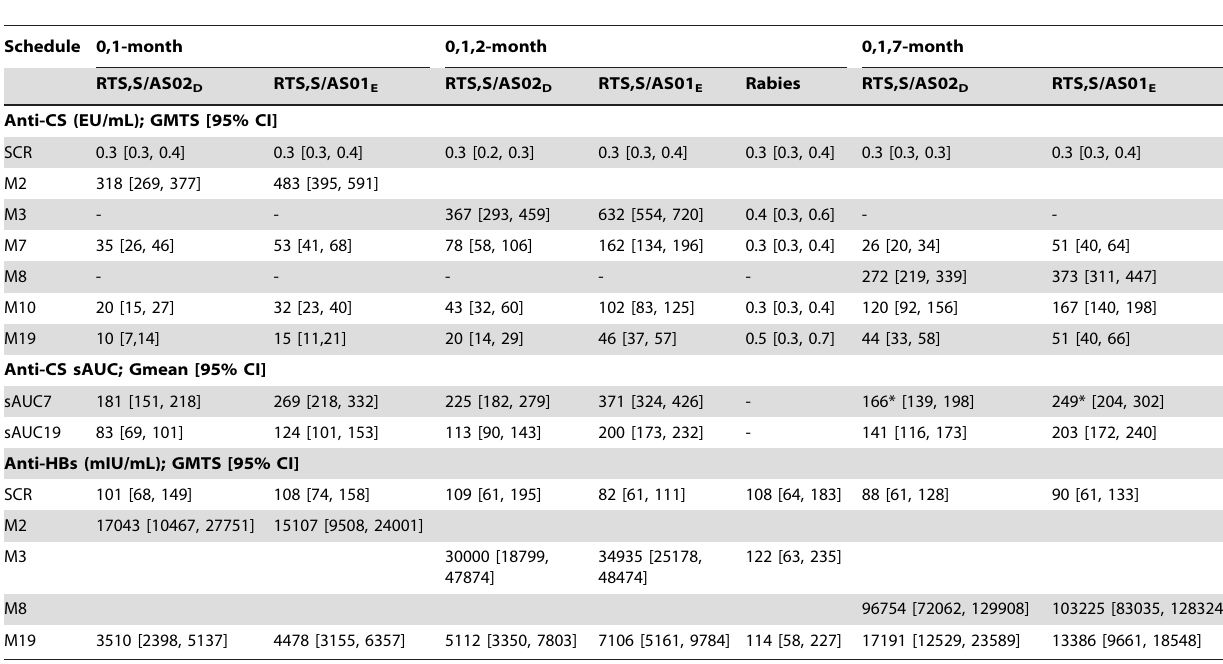
Table 3. GMTs and sAUC for anti-CS antibodies and GMTs for anti-HBs antibodies (ATP Cohort for